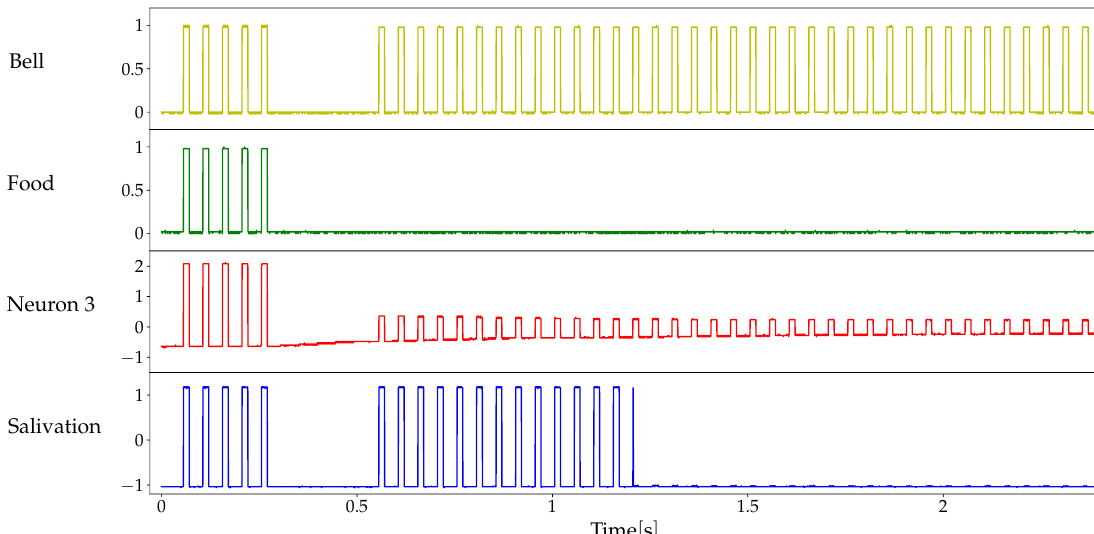
Figure 12. A typical example of the experiments to quantify memory persistence. After both stimuli are interrupted, only the conditioned stimulus (bell’s sound) is re-enabled. In this case, there are five blank spaces (no-stimuli lapse) and the memory persistence is measured as 14. Model parameters are as in Figure 10, except for τ 0 = 20s.